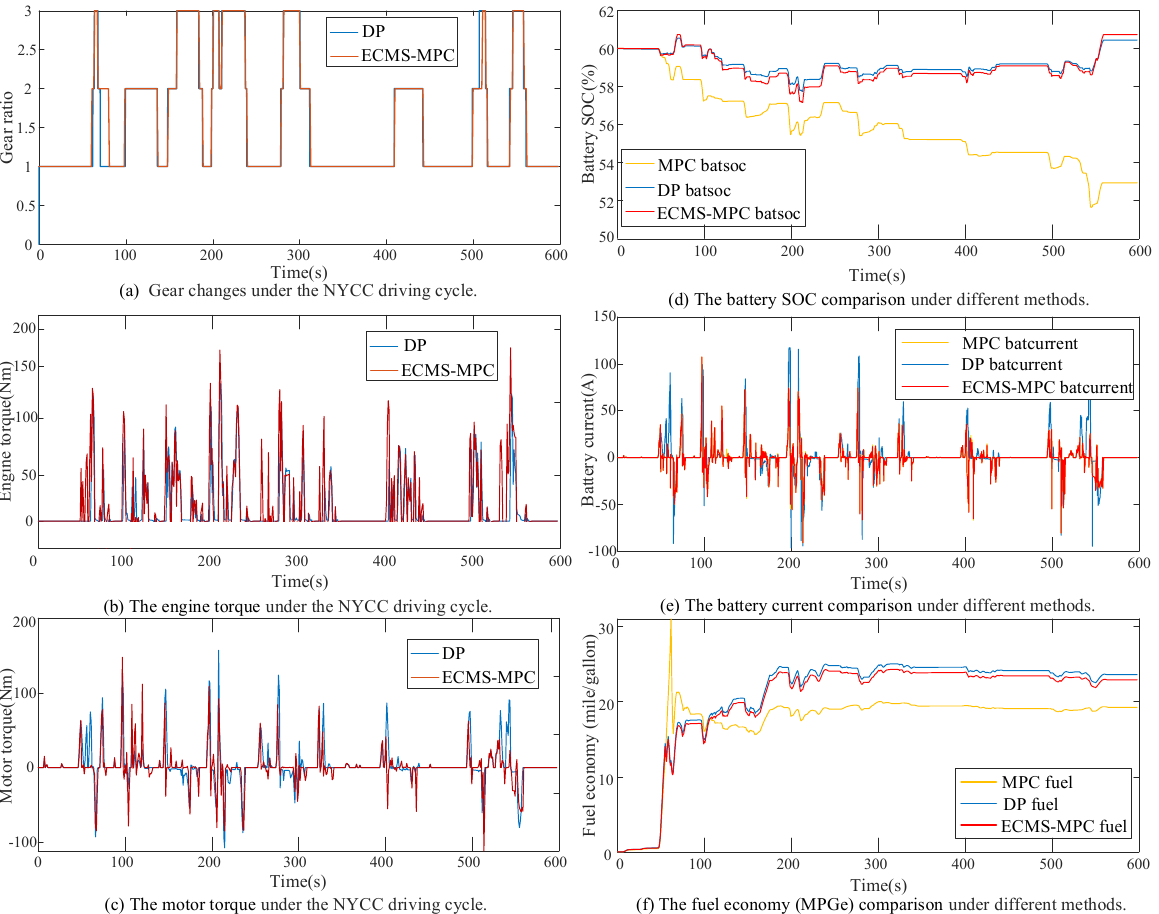
Figure 8. ( a – c ) The applied NYCC driving cycle and simulation in ECMS-MPC (5 s) and DP. ( d – f ) Comparison of the battery SOC and current when using different energy management strategies in the NYCC driving